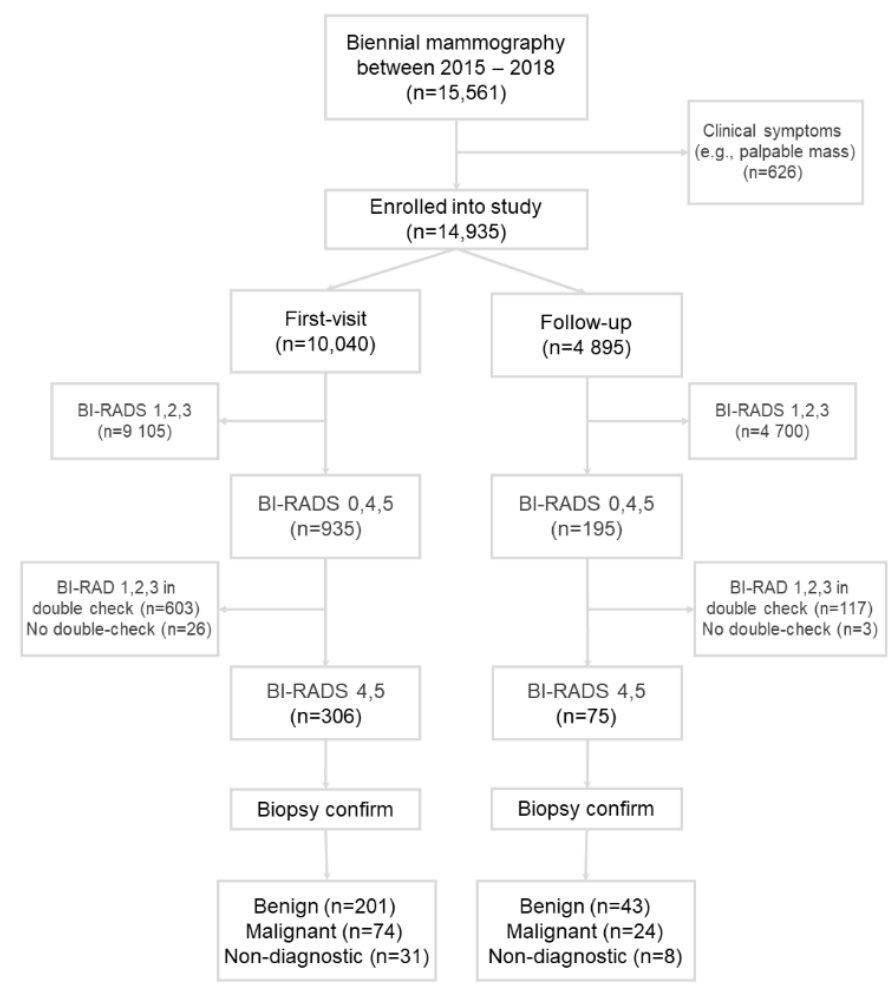
Figure 1. Flowchart of the